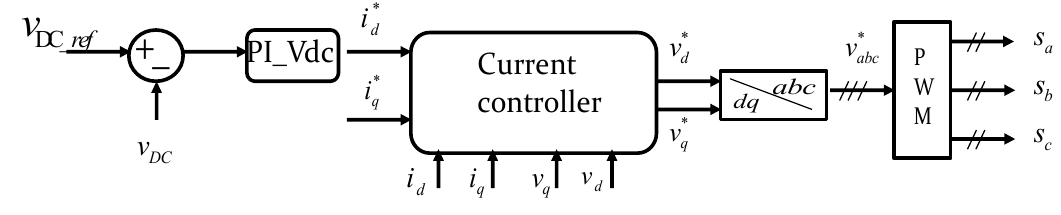
Figure 8. Current control loop.